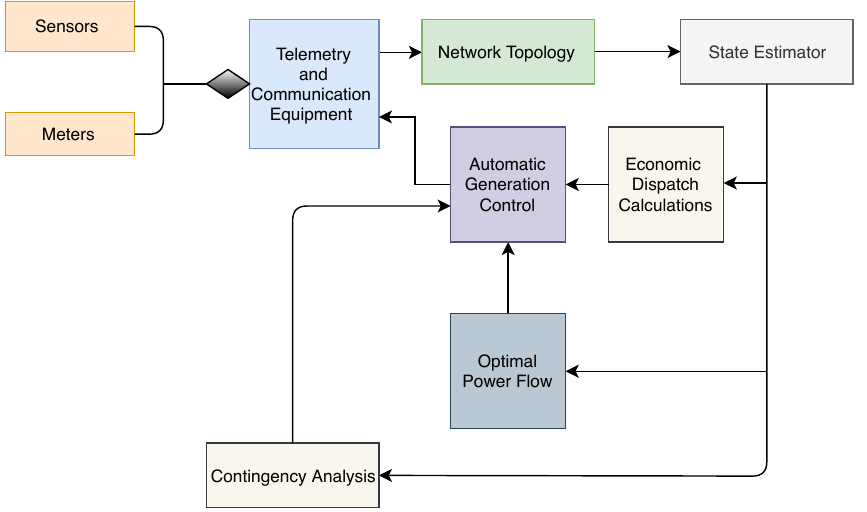
Figure 3. System architecture of the energy management system